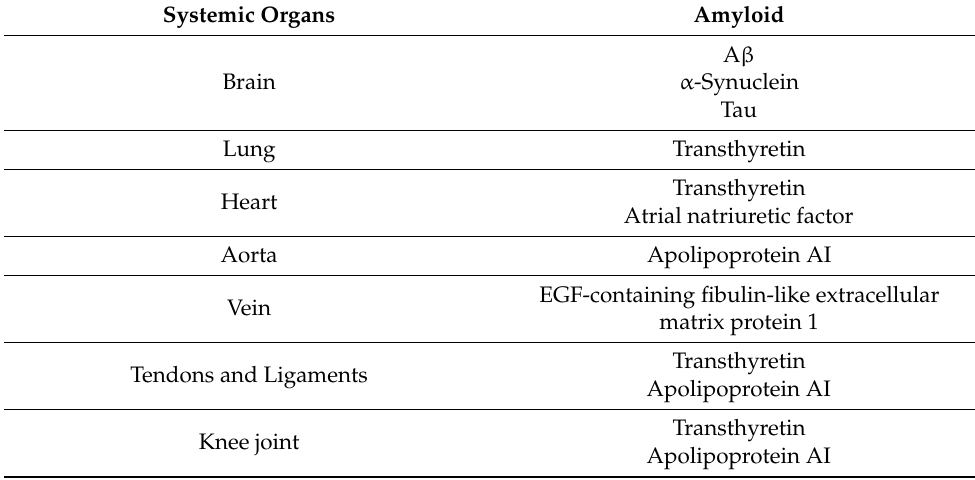
Table 1. Age-dependent amyloid distribution in selected organs [28].